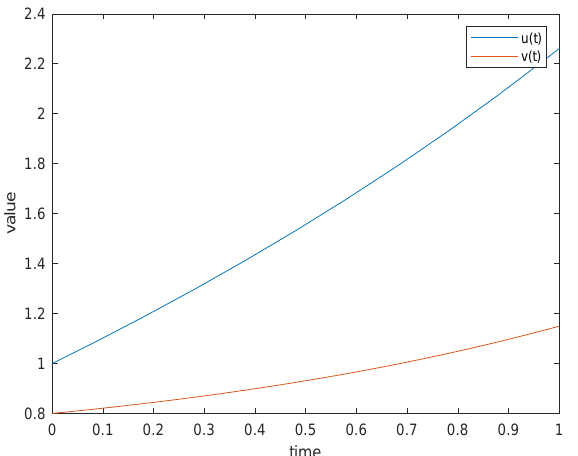
Figure 4. Numerical simulation of the integer-order equation solutions corresponding to Example